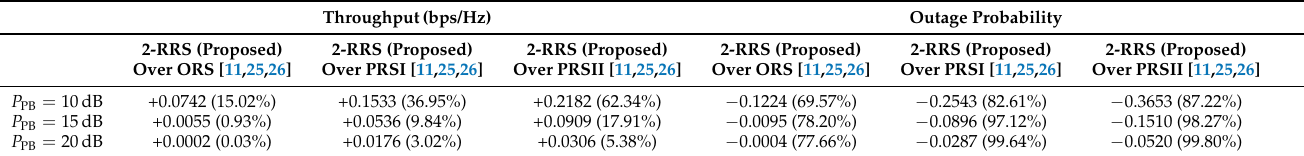
Figure 7. The outage probability comparison of the proposed 2-RRS scheme and the conventional PRS and ORS schemes versus the power beacon transmit power P PB with M = 8 and M = 64. Table 2. Throughput and Outage probability of our proposed 2-RRS scheme over the ORS and PRS relay selection schemes [11,25,26] with M = 64